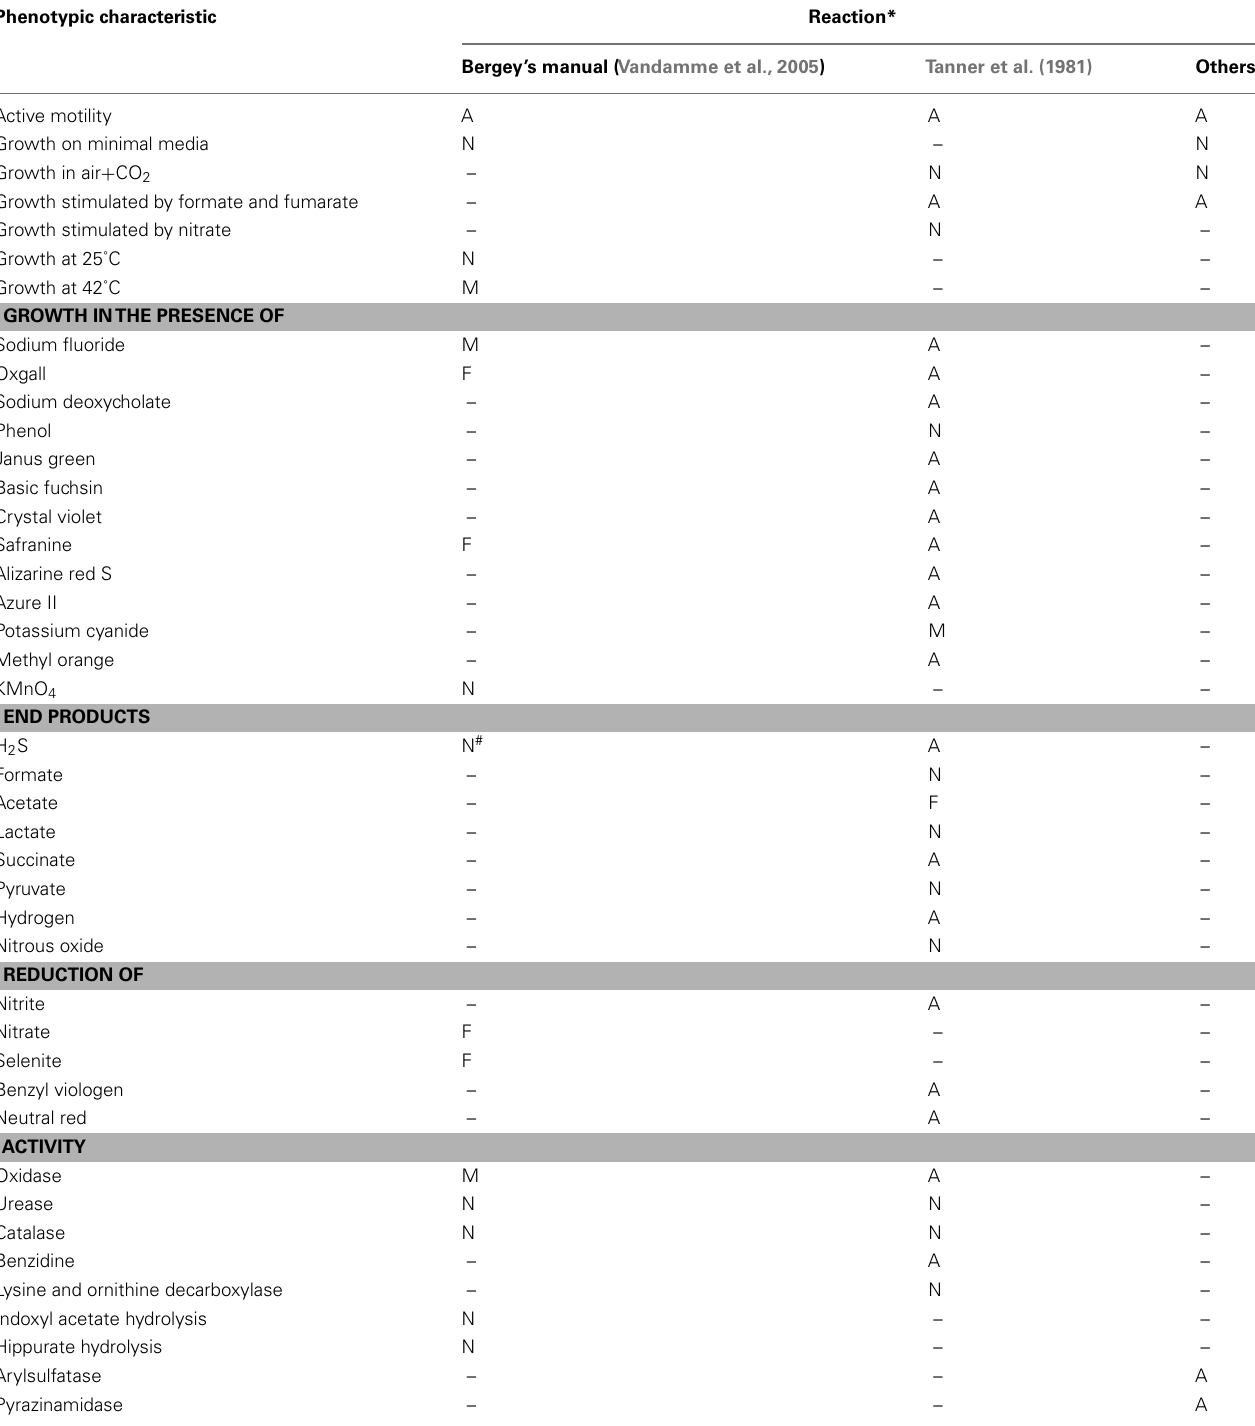
Table 1 | Phenotypic characteristics of Campylobacter concisus